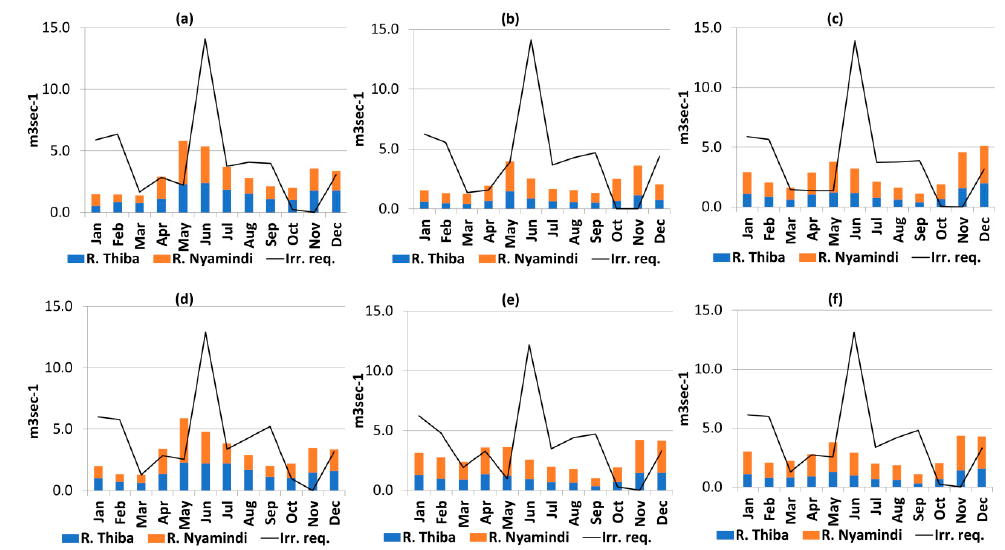
Figure 11. RCP 8.5 Comparison of total available flow and irrigation water requirements during